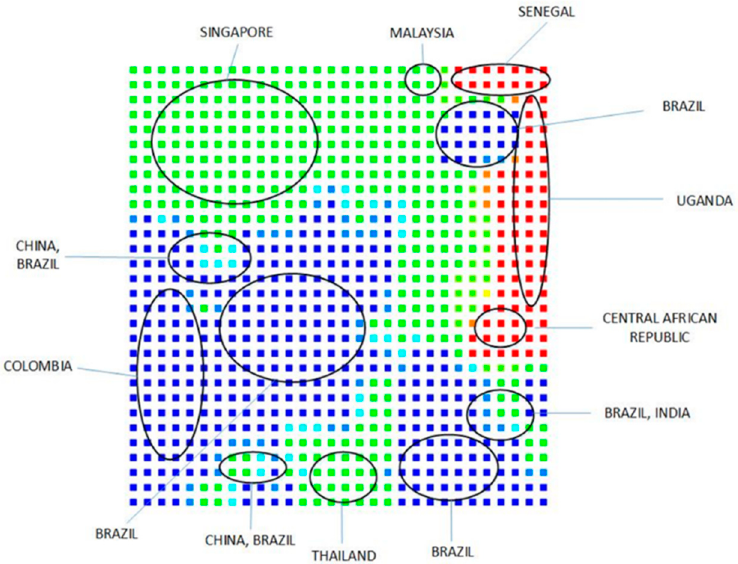
Figure 5. Distribution of objects in self-organizing map (SOM). Red, green, and blue areas represent Africa, Asia, and South America, respectively. Magenta represents overlap between Asia and South America and orange between Africa and Asia.